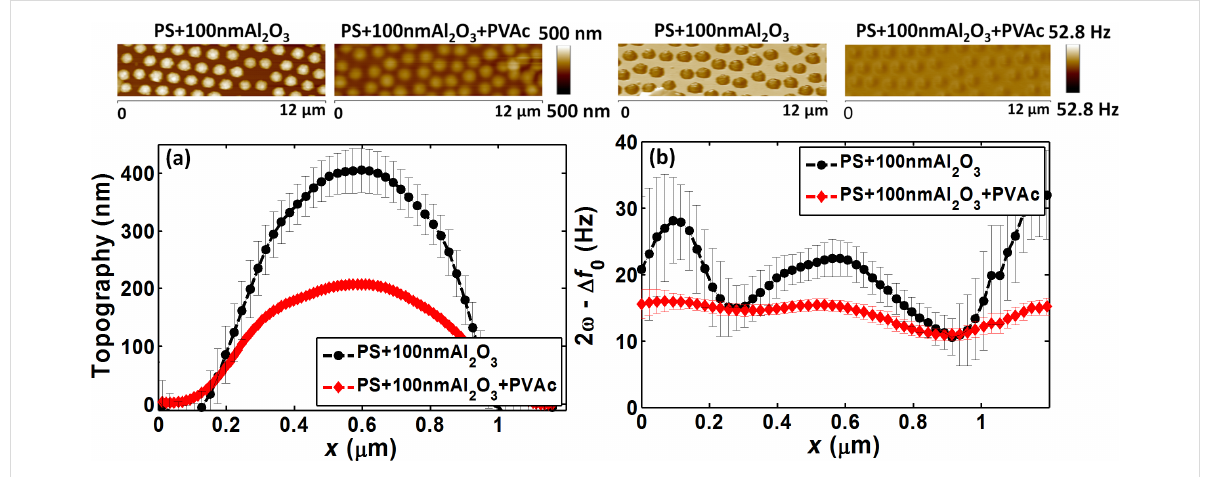
Figure 2: Approach 1 (PS + 100 nm Al 2 O 3 and PS + 100 nm Al 2 O 3 + PVAc samples): (a) average topography profiles, (b) average EFM signal profiles, and the corresponding AFM and EFM images (upper panels); tip–sample distance z ≈ 21 nm; reproduced with permission from [39], copy- right 2018 IEEE.